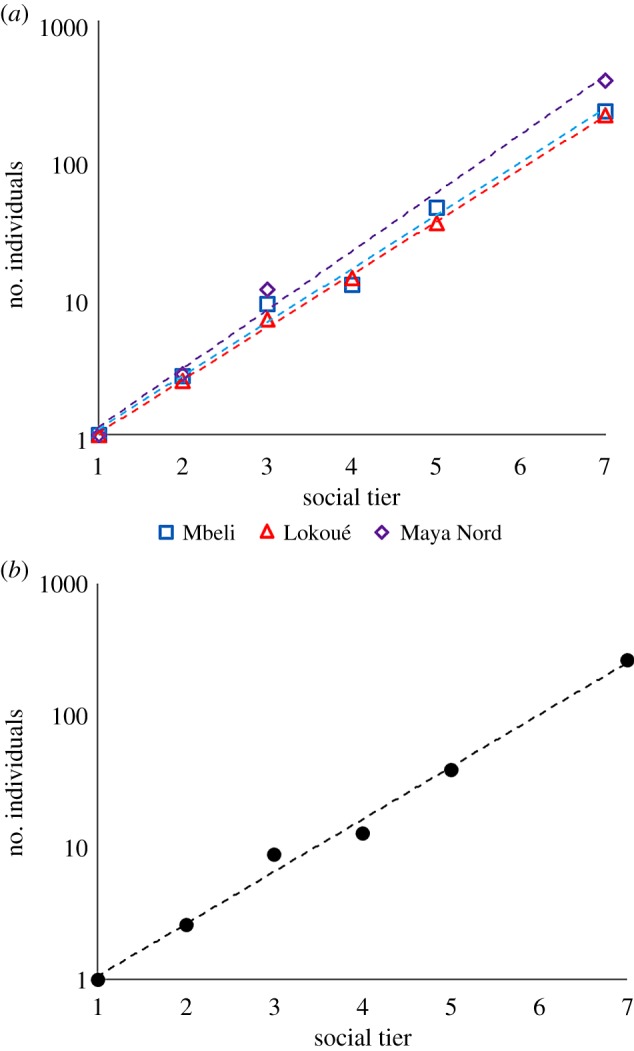
Social unit sizes across three gorilla populations follow a consistent scaling relationship close to that observed in other mammalian species showing HSM. Social tier values 1–7 represent g1 (individuals), mother–offspring units, g2 (family units), g3 (dispersed extended family group), g4 (aggregated group), g5 (sub-population), and g6 (overall population). (a) For three separate populations Mbeli (blue), Lokoué (red), Maya Nord (purple) with their fitted exponentials shown by dashed lines. (b) For the mean of social unit sizes at each level from all populations, with dashed line indicating the fitted exponential (scaling ratio = 2.70, R2 = 0.991, p = 6.37 × 10−10). (Online version in colour.)